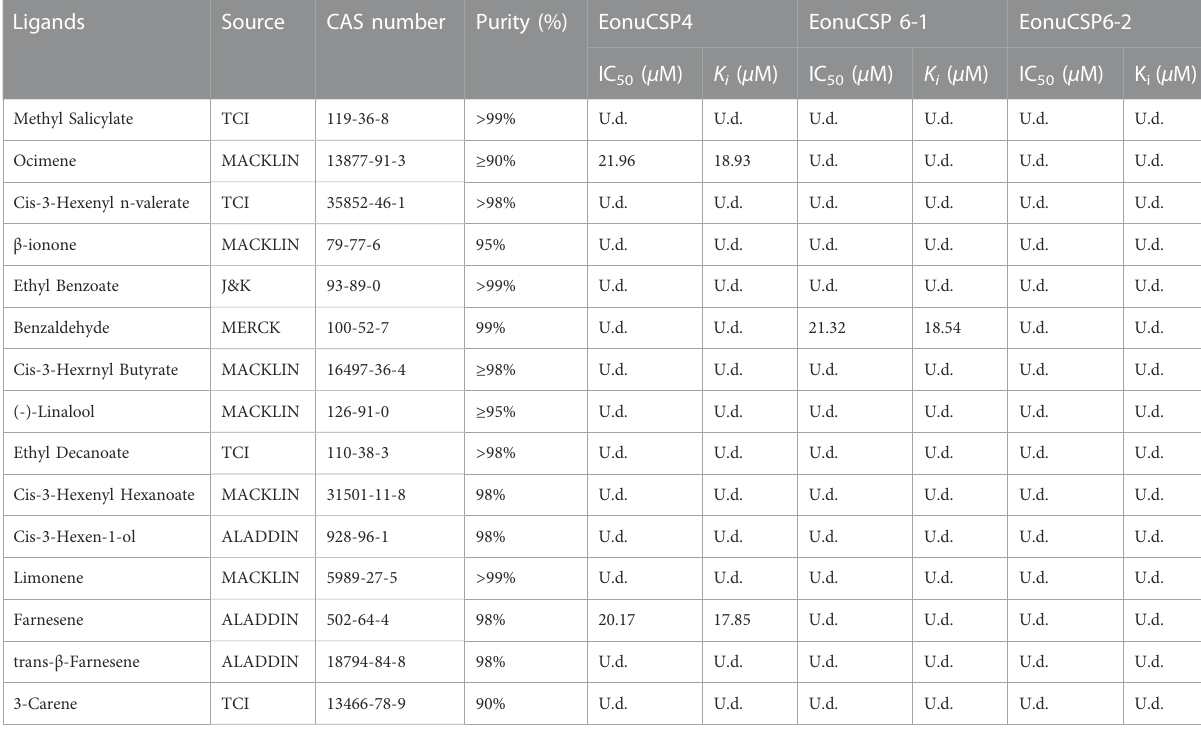
TABLE 1 Binding af fi nities of all tested ligands to the 3 CSPs in E. onukii.